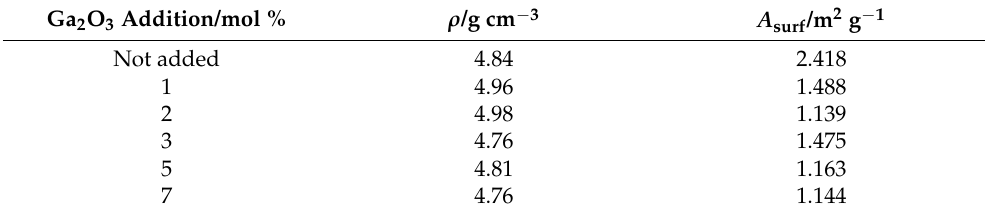
Figure 3. Constituent element (La, Zr, Ta, Ga and O) distributions on the fractured cross-sectional surfaces of Ta-doped LLZO sintered with ( a ) 2 mol % Ga 2 O 3 and ( b ) 5 mol % Ga 2 O 3 . The segregation areas of Ga and O in each sample are marked with white-lined circles. Table 1. Densities ρ and BET specific surface areas A surf of Ta-doped LLZO sintered with or without Ga 2 O 3 addition.